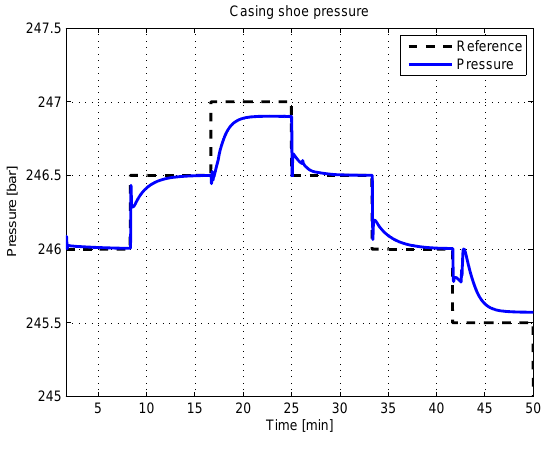
Figure 4: Step response models. Top row: Effect of flow and choke on p dh ( l bit ). Bottom row: Ef- fect of flow and choke on ∆ p dh .